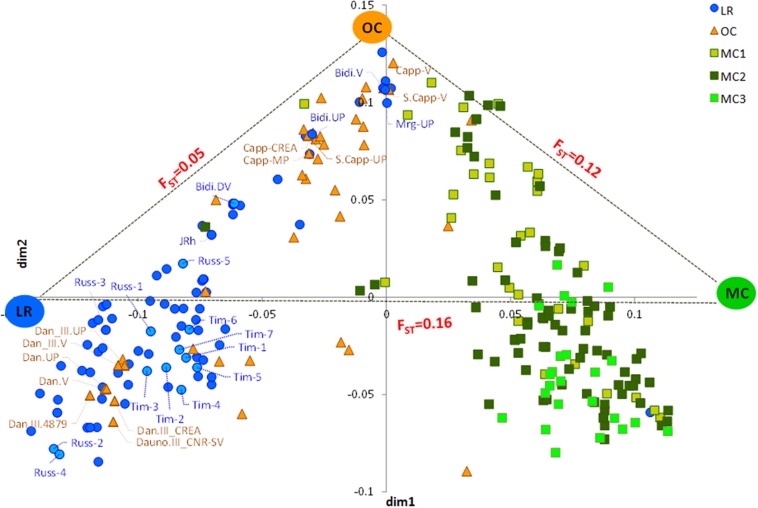
Multidimensional scaling (MDS) plot representing relationships between the 259 durum wheat accessions under investigation. The plot visualizes genome-wide IBS (identity-by-state) pairwise distances between accessions based on 3,541 SNP markers. Colors refer to five different groups (i.e., LR, OC, MC1, MC2, and MC3). Pairwise FST distance values between the three main sub-populations (i.e., LR, OC and MC) were also reported. LR, landraces; OC, old cultivars; MC, modern cultivars; Tim, TIMILIA; Russ, RUSSELLO; S. Capp, SENATORE CAPPELLI; JRh, JEAN RHETIFAH; Mrg, MARGHERITO; Dan, DAUNO.